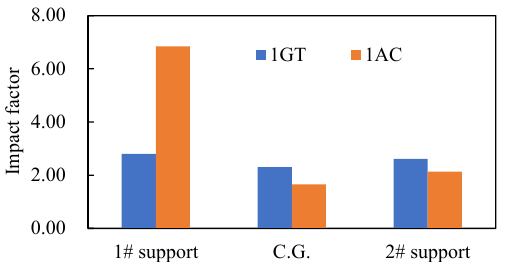
Figure 20. Impact factors for the blade off occurring at two different locations.